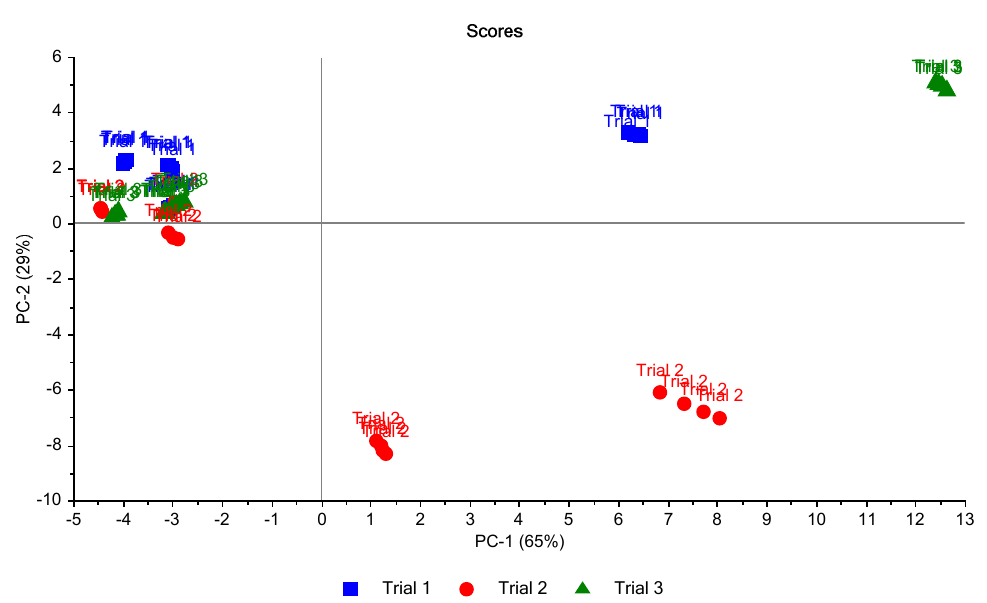
Figure 11. Scores plot of the 16 samples in the three trials classified according to the trials. A clear separation between health samples (on the left) and others (on the right) is shown.